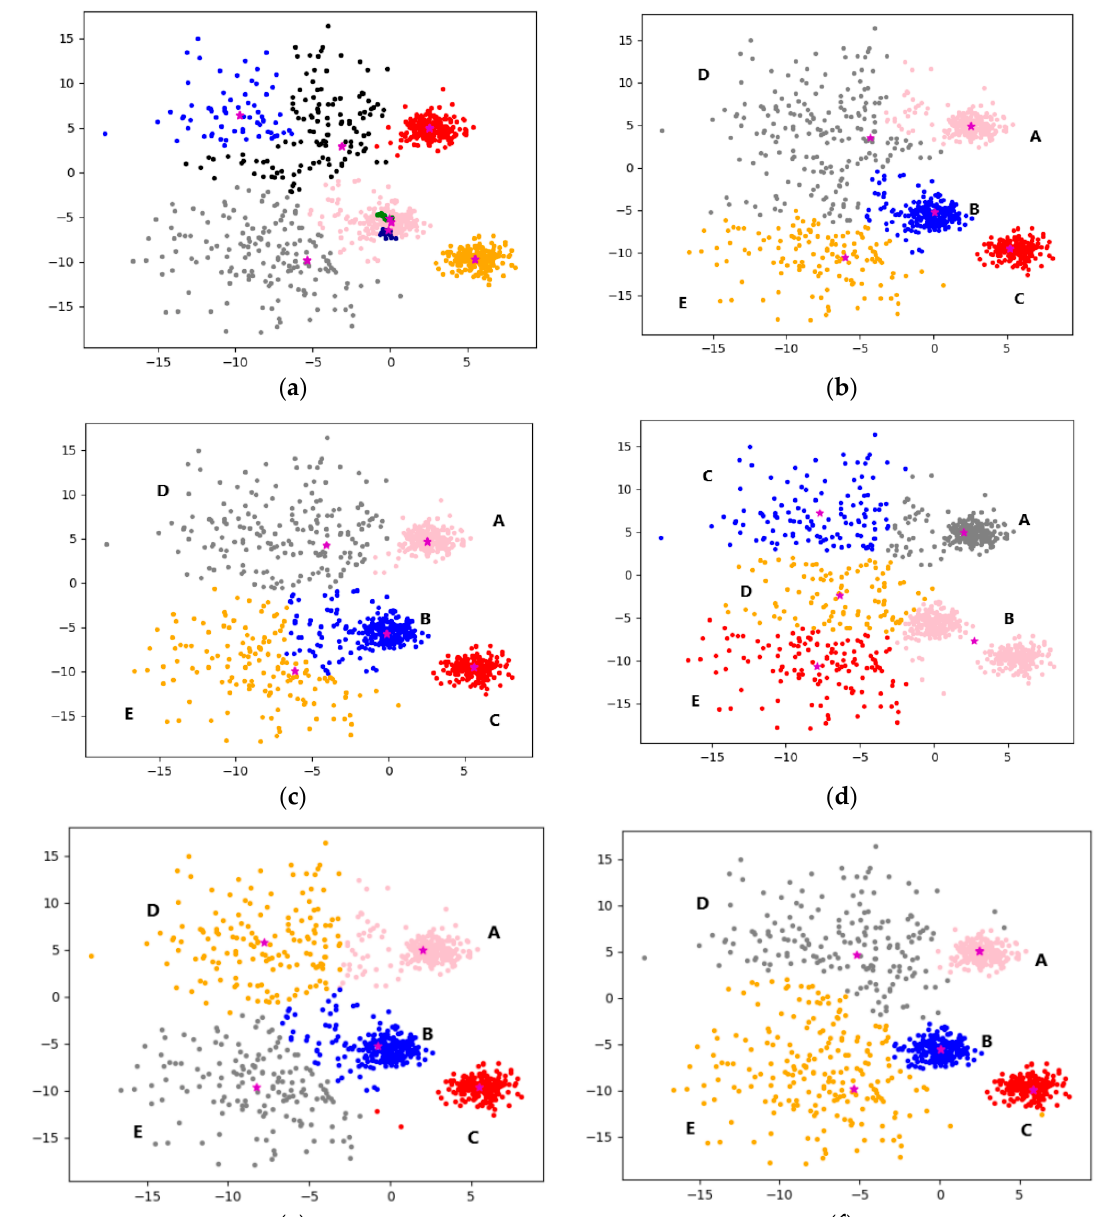
Figure 9. Clustering effect comparison chart [17,18]. ( a ) DPC ( n = 1000, C = 8). ( b ) DPC ( n = 1000, C = 5). ( c ) Reference [17] ( n = 1000, C = 5). ( d ) K-means ( n = 1000, C = 5). ( e ) Reference [18] ( n = 1000, C = 5). ( f ) F-DPC ( n = 1000, C =